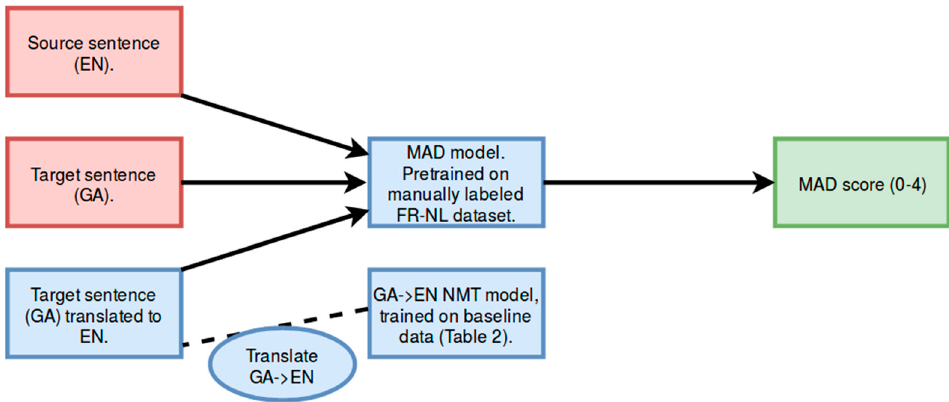
Figure 2. Illustration of how MAD can be applied on the EN–GA corpus.